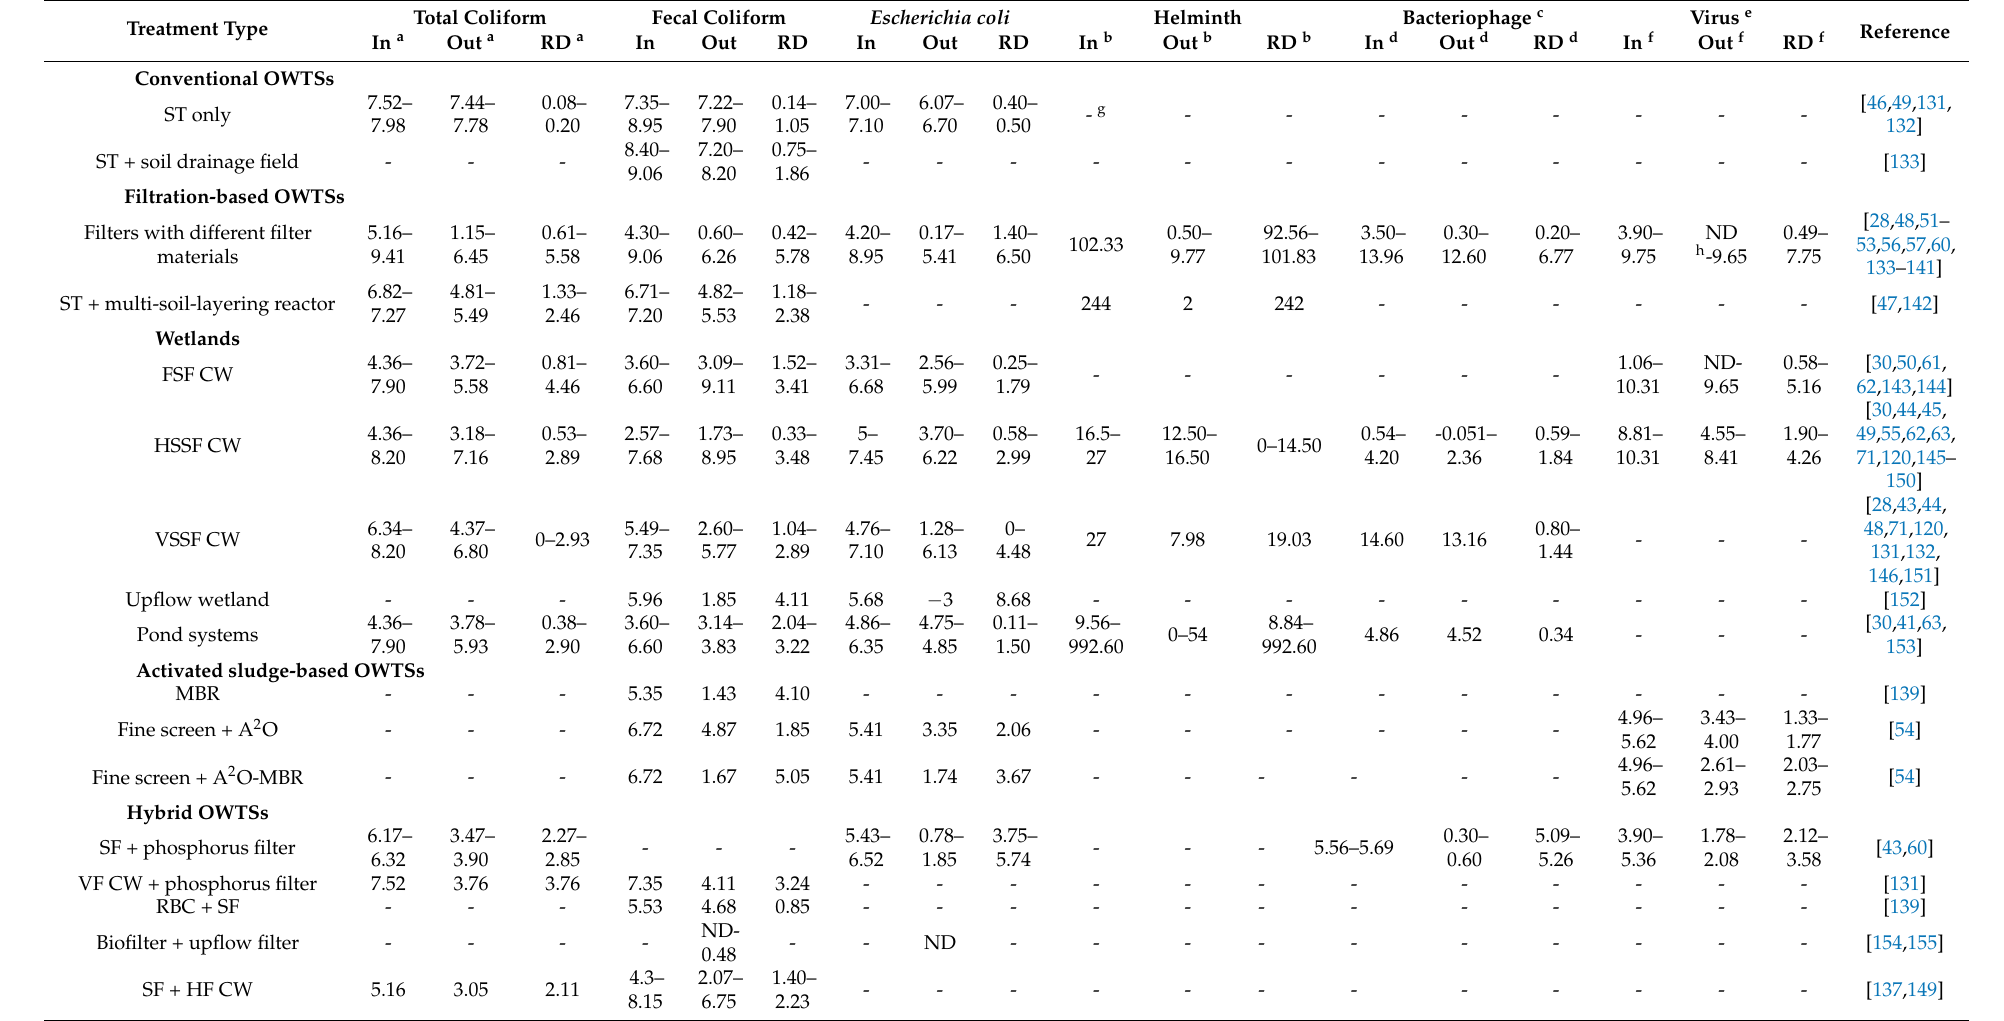
Table 2. Performance of pathogen removal in various